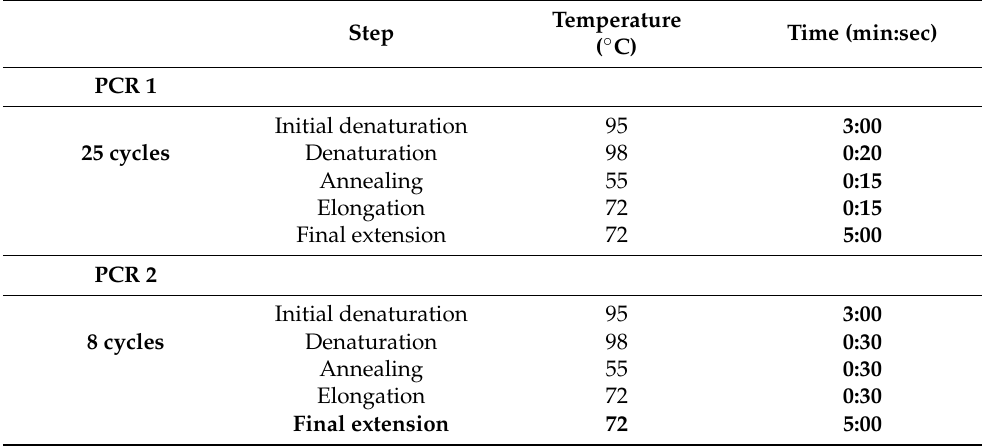
Table 5. PCR conditions used for next-generation sequencing with Illumina for initial amplification of 16S rRNA gene region (PCR 1) as well as for the index PCR (PCR